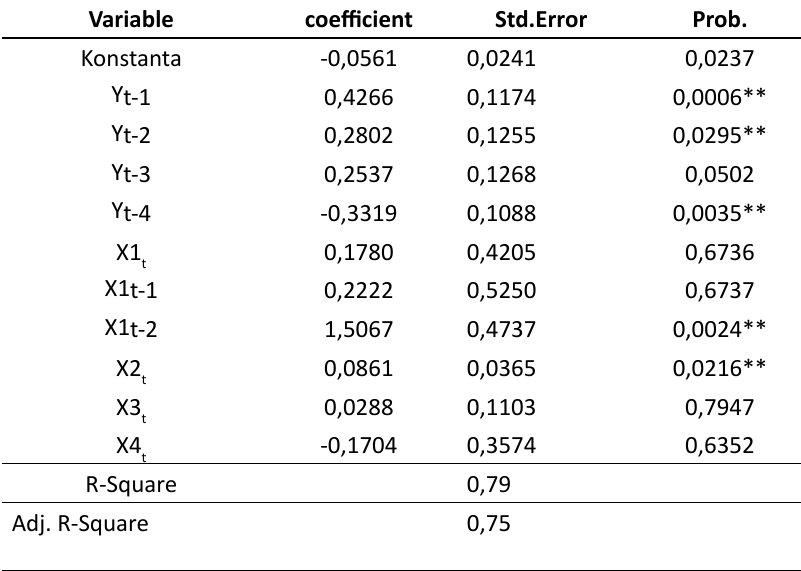
Table 5: ARDL Estimation